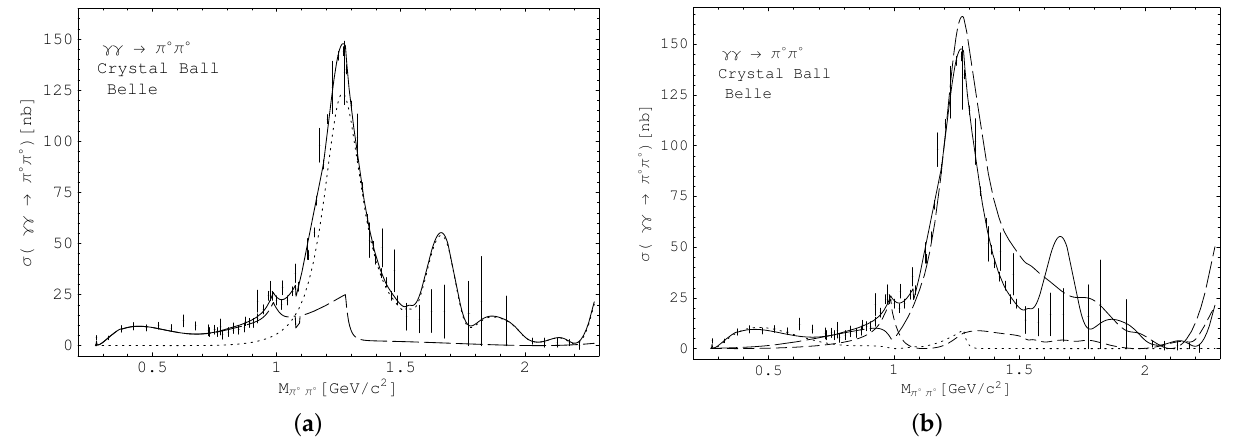
Figure 1. Description of the cross section of the γγ → π 0 π 0 process. The experimental data are taken from the Crystal Ball [1] and Belle [2,3] Collaborations. ( a ): Full result for the cross section (solid line) is compared with contributions of the S -wave (long-dashed line) and D -wave (dotted line). ( b ): Full result for the cross section (solid line) is compared with contributions of the coupled channels to the calculated energy spectrum by the ππ channel (long-dashed line); KK channel (dotted line); ηη channel (short-dashed